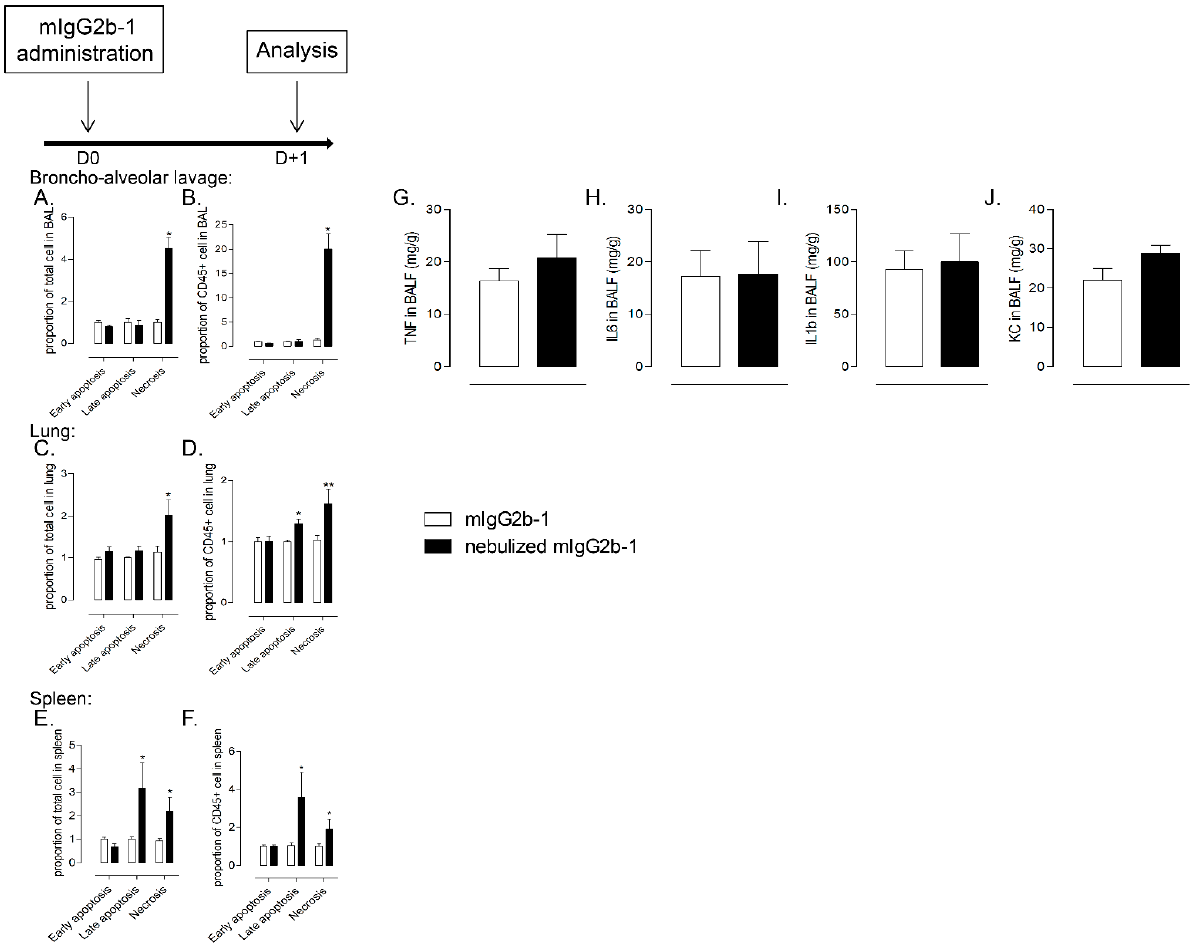
Figure 5. B6 mice received a single 40 µL orotracheal instillation of mIg2b-1 at 100 µg/mL either native (white bars) or nebulized (black bars). The proportion of early apoptotic cells (Annexin-V+/PI-), late apoptotic cells (Annexin-V+/PI+) and necrotic cells (Annexin-V-/PI+) were quantified in total cell ( A , C , E ) or CD45+ cell ( B , D , F ), 18 h after the administration in BAL ( A , B ), lungs ( C , D ) and spleen ( E , F ) relative to mice treated with native Ab using flow cytometry. The concentrations of TNF ( G ), IL6 ( H ), IL1b ( I ) and KC ( J ) in BALF were determined 18 h after the administration. The data are quoted as the mean ± SEM. *, **: p < 0.05 and p < 0.01, respectively, in a t-test. The results are representative of three independent experiments ( n = 5 mice/experiment).